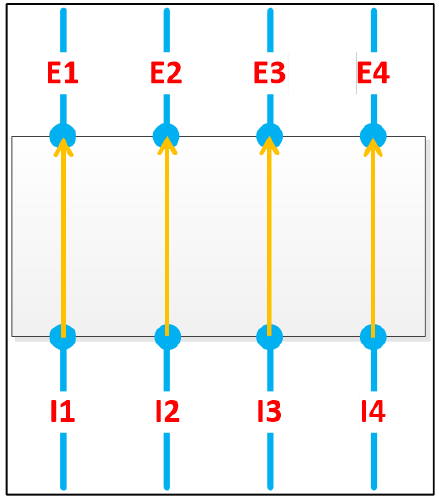
Figure 5. MUXER in normal conditions.